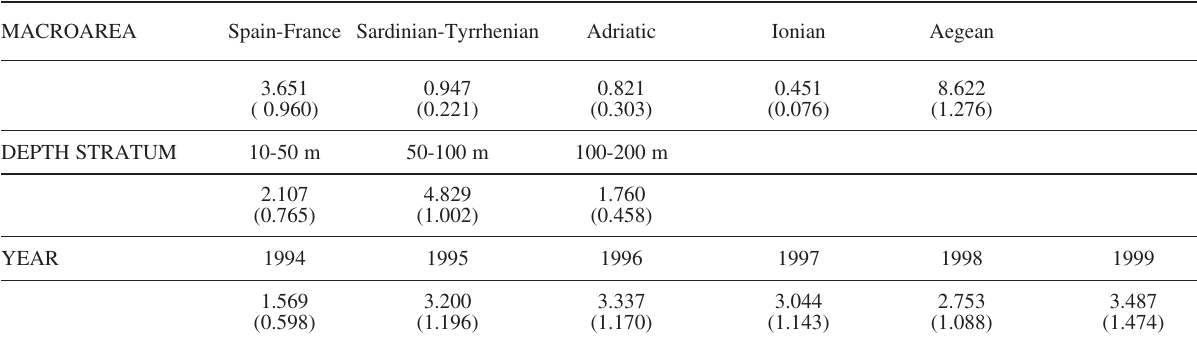
T ABLE 4. – Citharus linguatula : mean biomass indices, expressed in kg/km 2 (with standard error, in brackets), estimated from the MEDITS trawl surveys by macro-area, depth stratum and